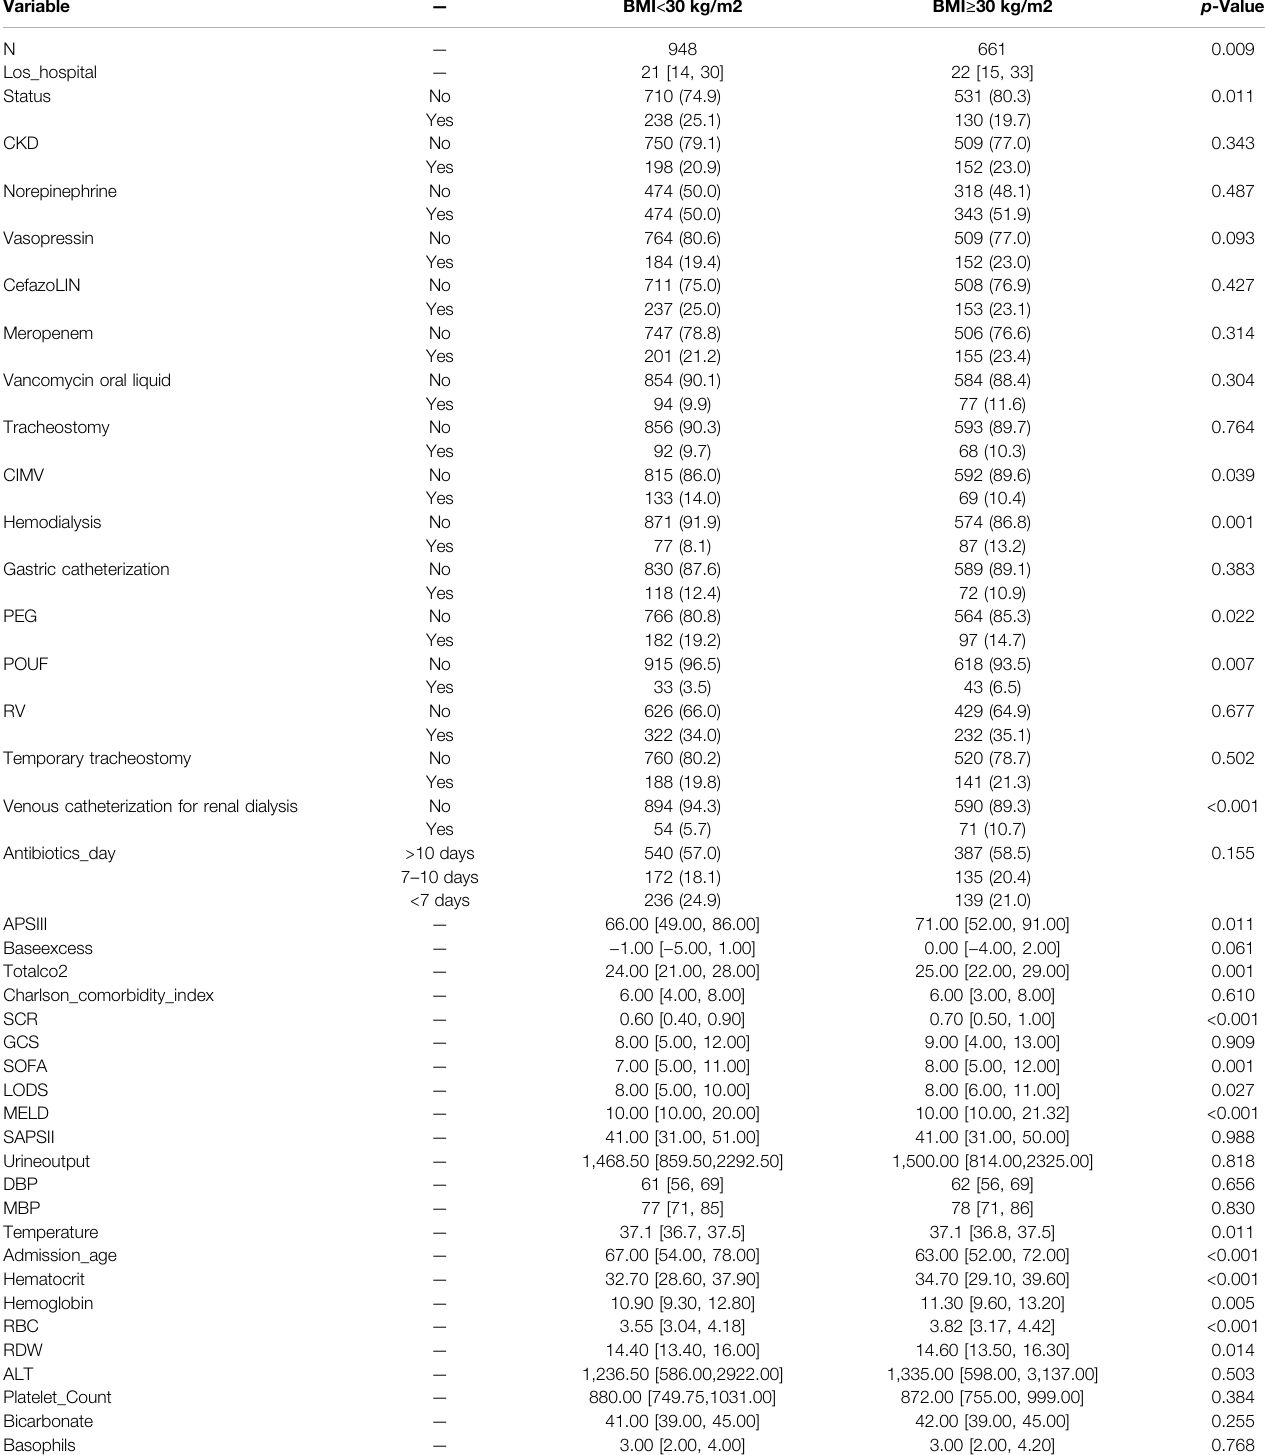
TABLE 4 | Baseline characteristics between different BMI groups.